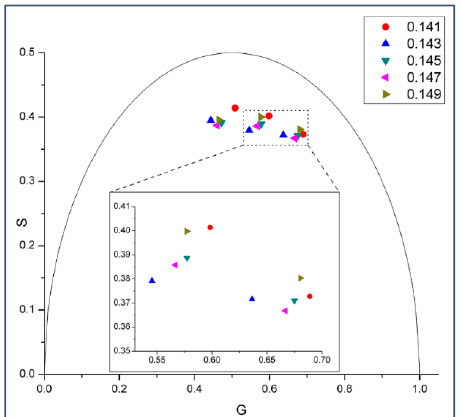
Figure 4. Effect of gA mole fraction on the phasor dots of gramicidin fluorescence lifetime in gA/DMPC large unilamellar vesicles (LUVs). In this sample set, five gA mole fractions (0.141, 0.143, 0.145, 0.147, 0.149) were examined. Samples were measured at 37 °C using 3 different modulation frequencies (from left to right) 200.00, 143.94, and 103.59 MHz. The semi-circular arc is called the “universal circle” [21]. Inlet: enlarged phasor data measured at 143.94 and 103.59 MHz; the relative errors of G and